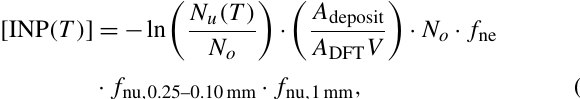
where N ice is the number of frozen drops (dimensionless) and N droplets is the number of unfrozen droplets (dimensionless) (Kanji et al.,